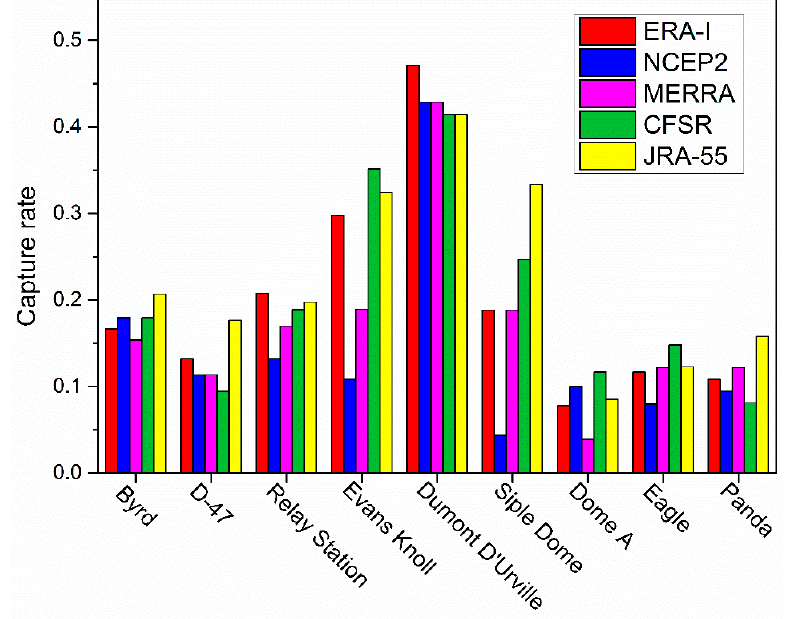
Figure 7. The capture rate of the high precipitation events for the five reanalyses.